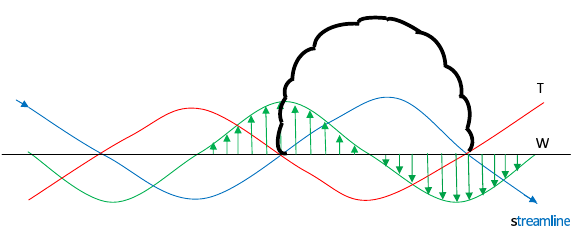
Fig. 10. Ideal structure of a wave cloud. The cloud occurs between the maximum and minimum of vertical velocity, where the temper- atures are below the undisturbed mean